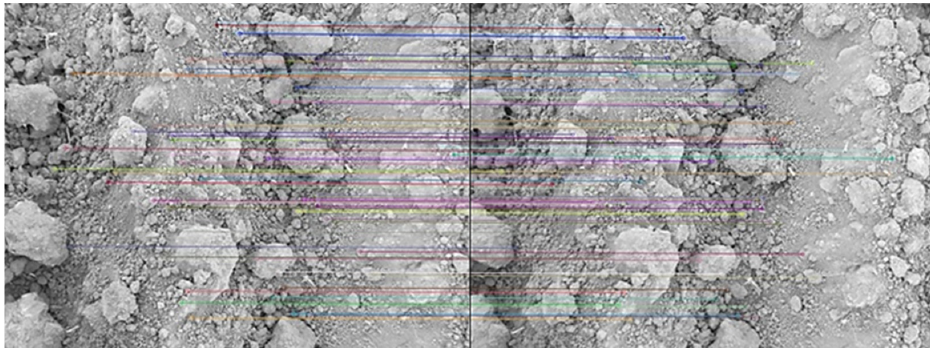
Figure 5. Illustration of matched keypoints using the brute force algorithm.